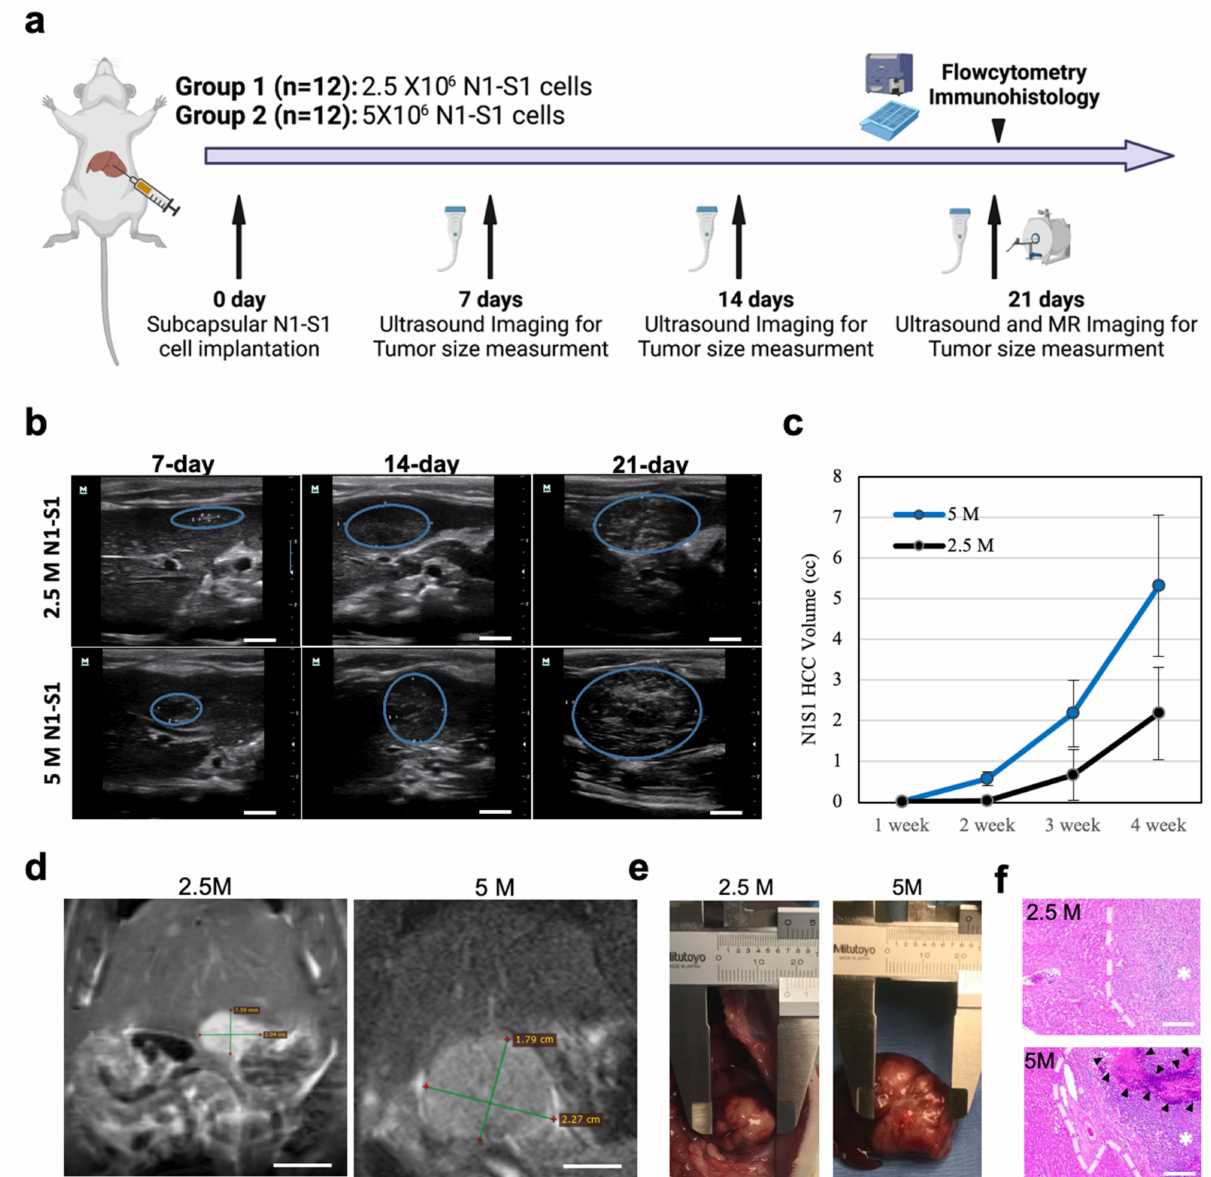
Figure 1. ( a ) Schematic summary of experimental groups and procedure. Rats in Group 1 were implanted with 2.5 × 10 6 N1-S1 cells and rats in Group 2 were implanted with 5 × 10 6 N1-S1 cells. The tumor size was tracked with ultrasound and MR imaging for 3 weeks. Harvested tumor and liver parenchyma tissues were analyzed with immunohistochemistry. ( b ) Ultrasound imaging and tumor size tracking of N1-S1 rats generated with 2.5 and 5 million N1-S1 cell implantations. Blue circles are tumors. Scale bars are 1 cm. ( c ) Time-dependent tumor volume changes measured in ultrasound imaging. ( d ) MR T2 weighted images of N1-S1 tumors generated by 2.5 or 5 × 10 6 N1-S1 cells at 3 weeks post-implantation. Scale bars are 1 cm. ( e ) Gross tissues images from each experimental group. ( f ) H&E-stained tissues showing the tumor borders (white dotted lines) from each group. (*: tumor region and black arrows: tumor central necrosis region). Scale bars are 100 µ